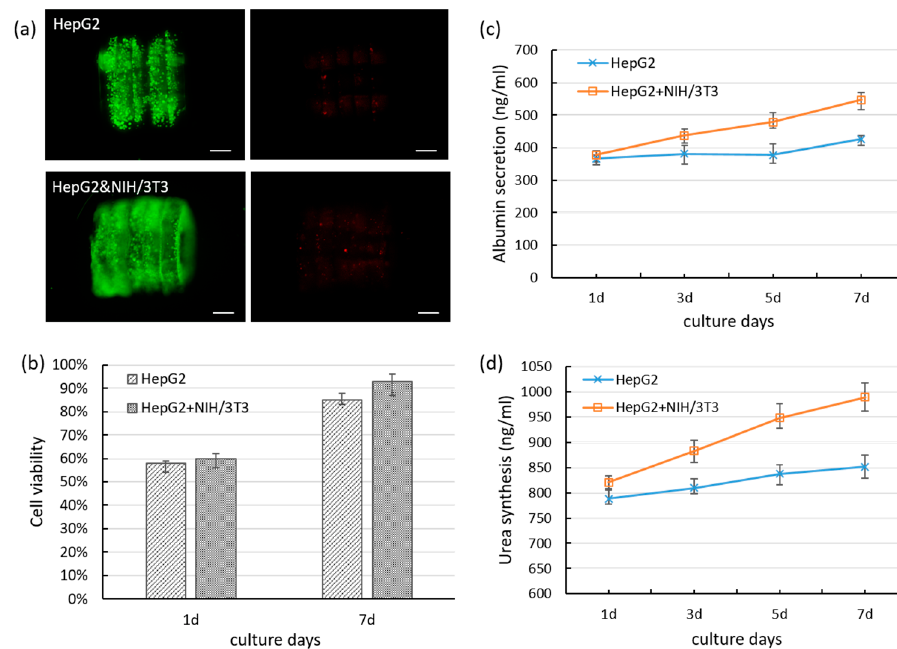
Figure 4. ( a ) Live/dead staining of mono-cultured 3D lobule-like microtissues and co-cultured 3D microtissues after 7 days of culture, scale bar: 200 µ m; ( b ) The cell viability of mono-cultured 3D microtissues which encapsulating HepG2 cells and co-cultured 3D microtissues which encapsulating HepG2 cells and NIH / 3T3 cells; ( c ) The evaluation of albumin secretion of HepG2 cells in mono-cultured 3D microtissues and co-cultured 3D microtissues during long-term culture; ( d ) The evaluation of urea synthesis of HepG2 cells in mono-cultured 3D microtissues and co-cultured 3D microtissues during culture.